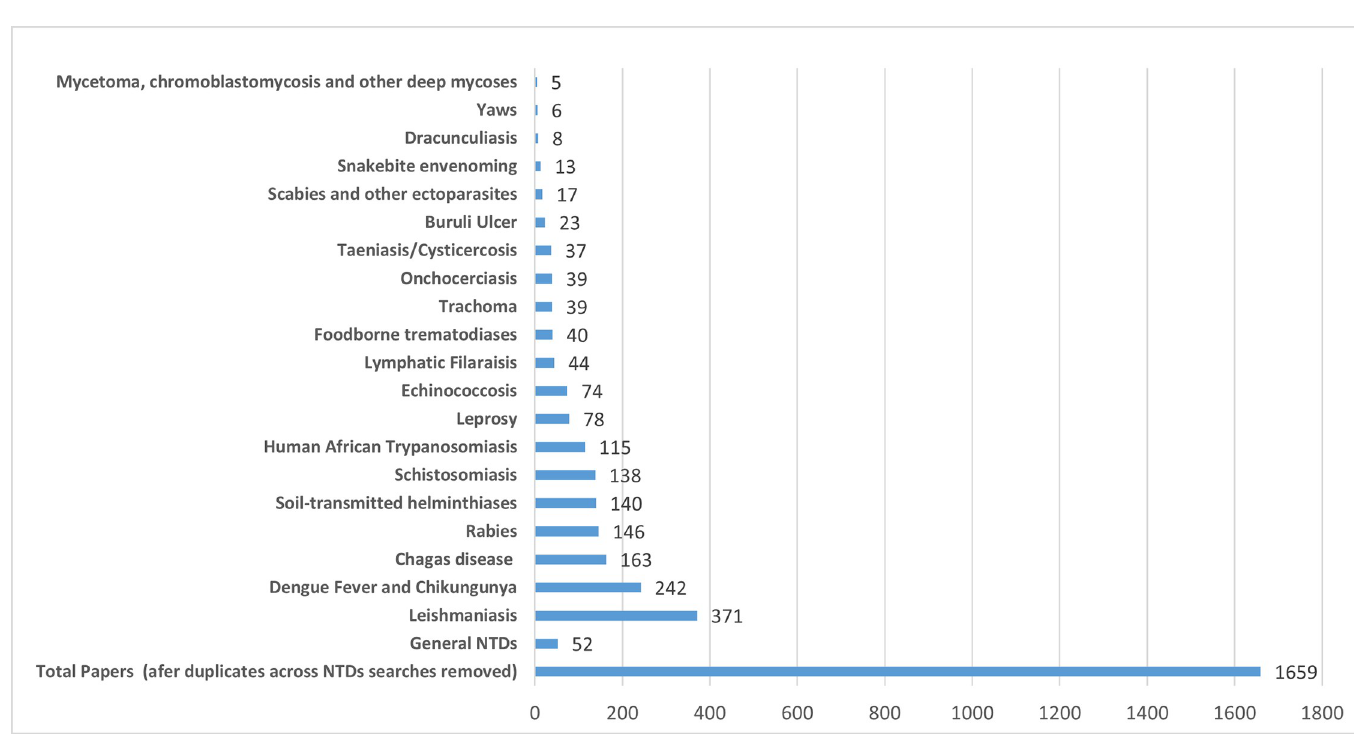
Fig 4. Canadian contributions to research on the 20 NTDs (2010–2019). NTD, neglected tropical disease.